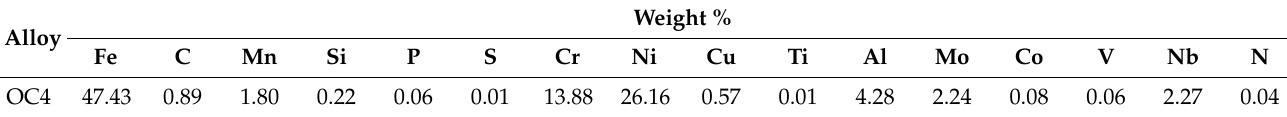
Table 2. Chemical composition of the AFA